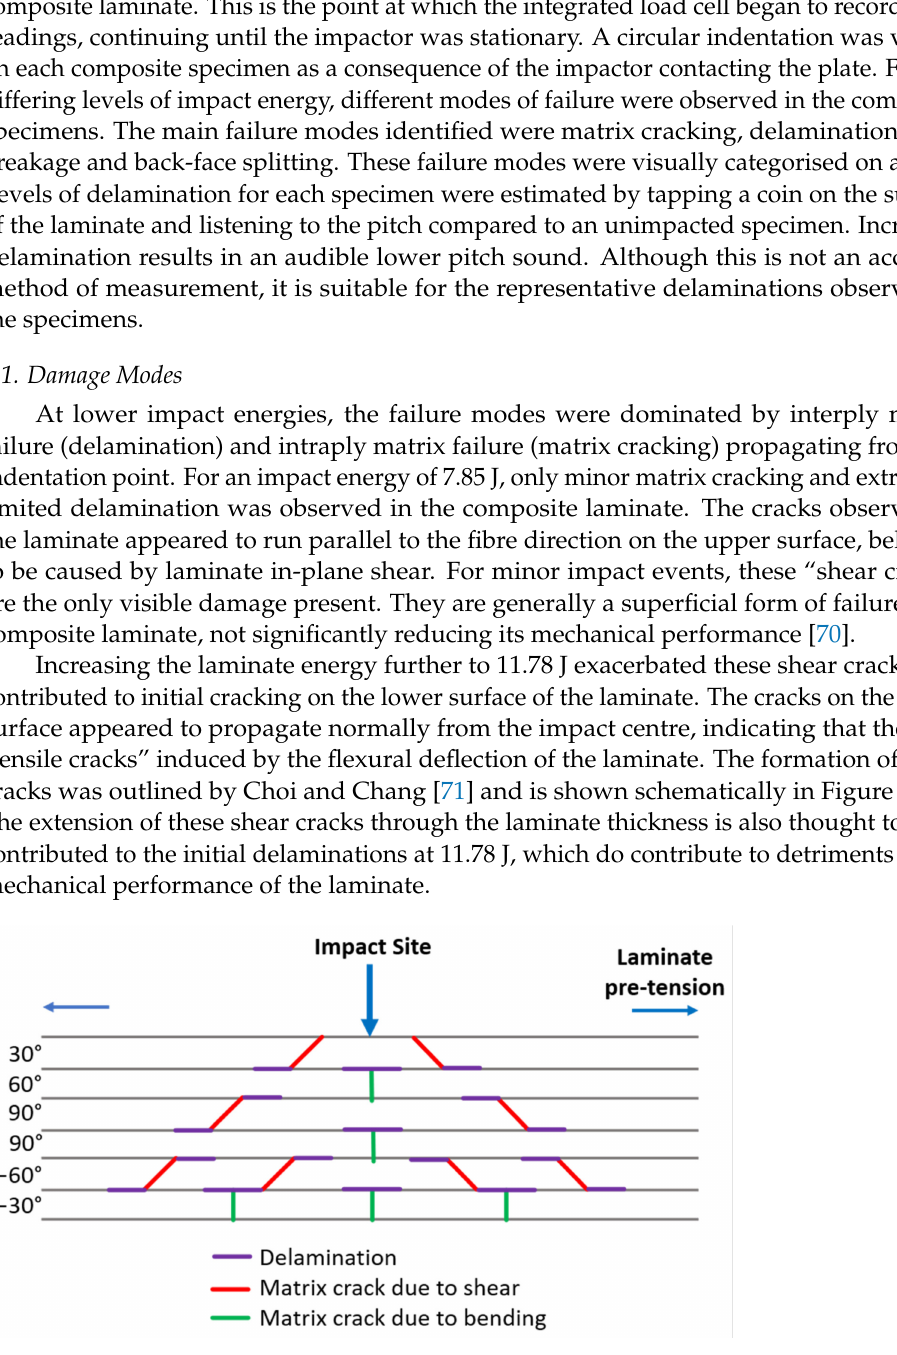
Figure 9. Schematic of internal cracks and delaminations that form within a composite laminate after impact